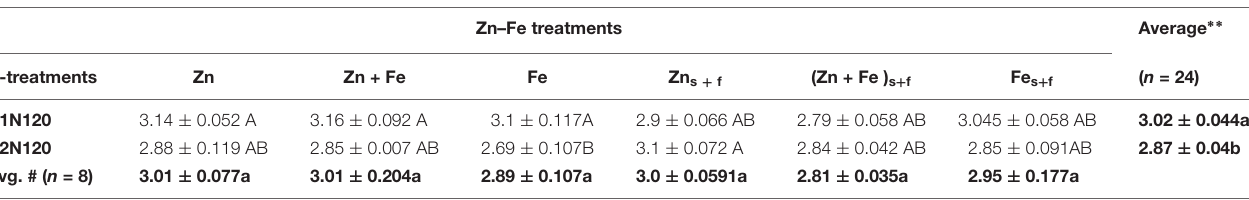
TABLE 3 | Mean ± 1 SE grain yield (g pot − 1 ) at experiment with growth media plus foliar application of Zn and Fe. Zn–Fe treatments Average ∗∗